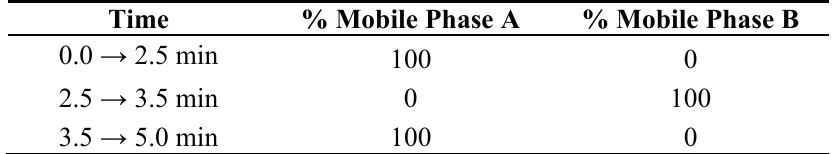
Table 2. Elution program for the quantification of IgG 1 by affinity